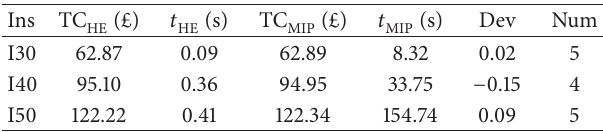
Table 6: Impact of the maximum ride time